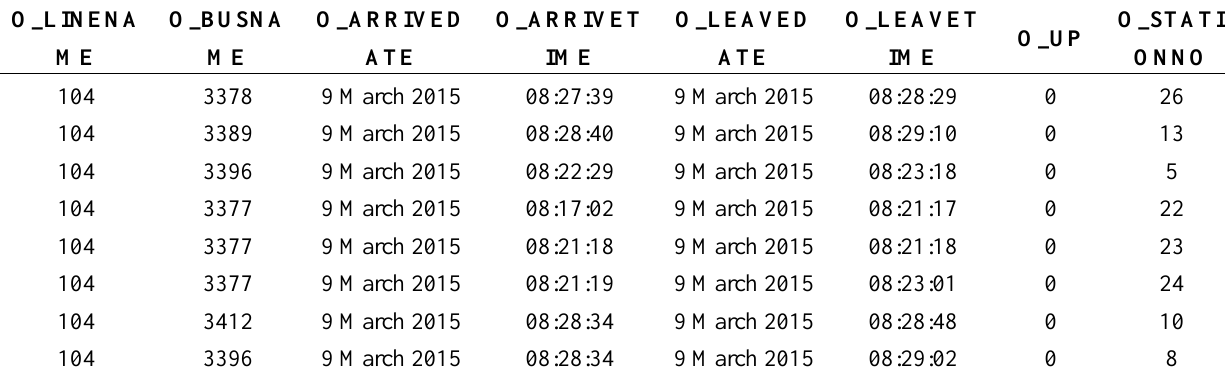
Table 1. Information used in the research among the bus GPS data (sample